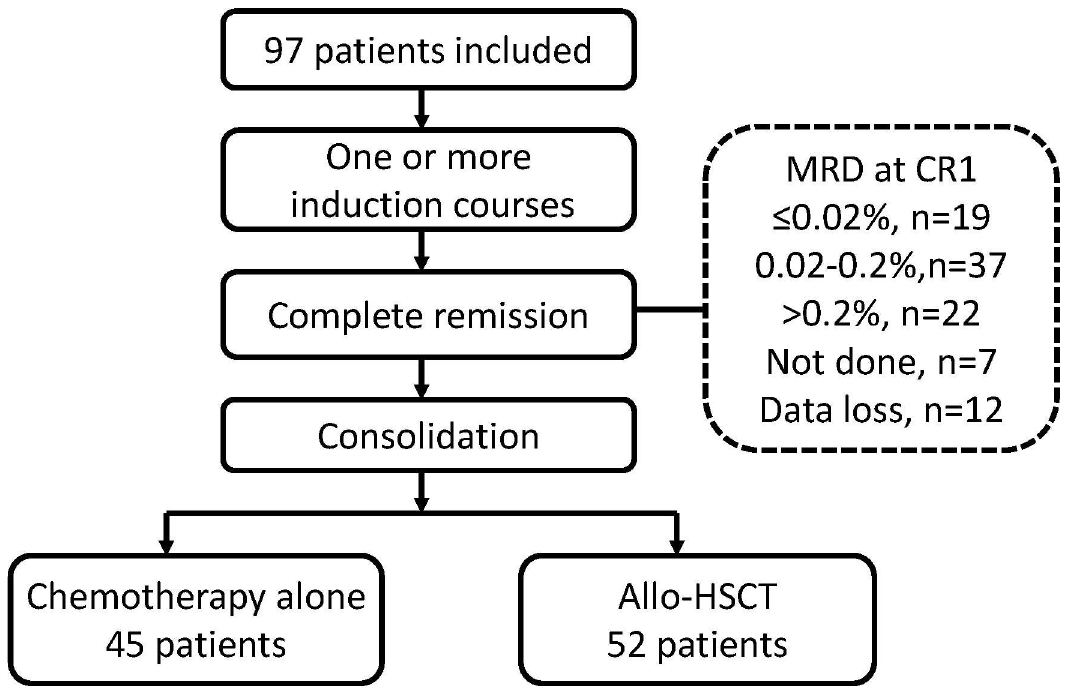
Fig 1. Patient Flow